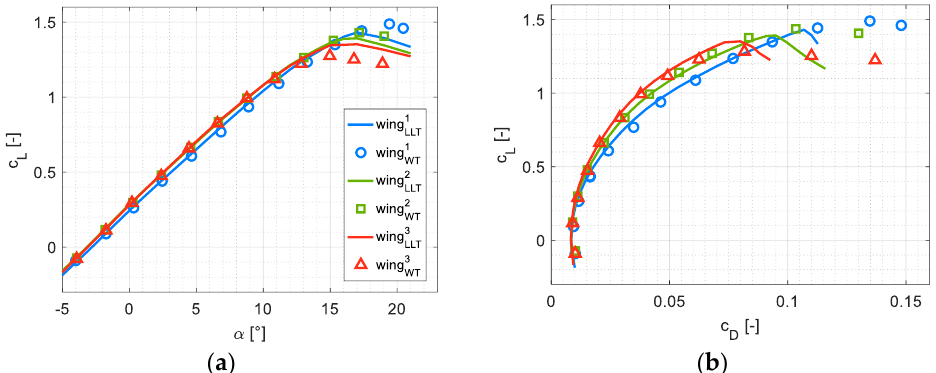
Figure 2. Comparison of computed (lines) and wind tunnel measured (circles) three wings aerody- namic characteristics. Lift coefficient as function of angle of attack ( a ) and lift coefficient as function of drag coefficient ( b ). Table 2. Summary of geometrical, aerodynamic, and mass characteristics of wings.